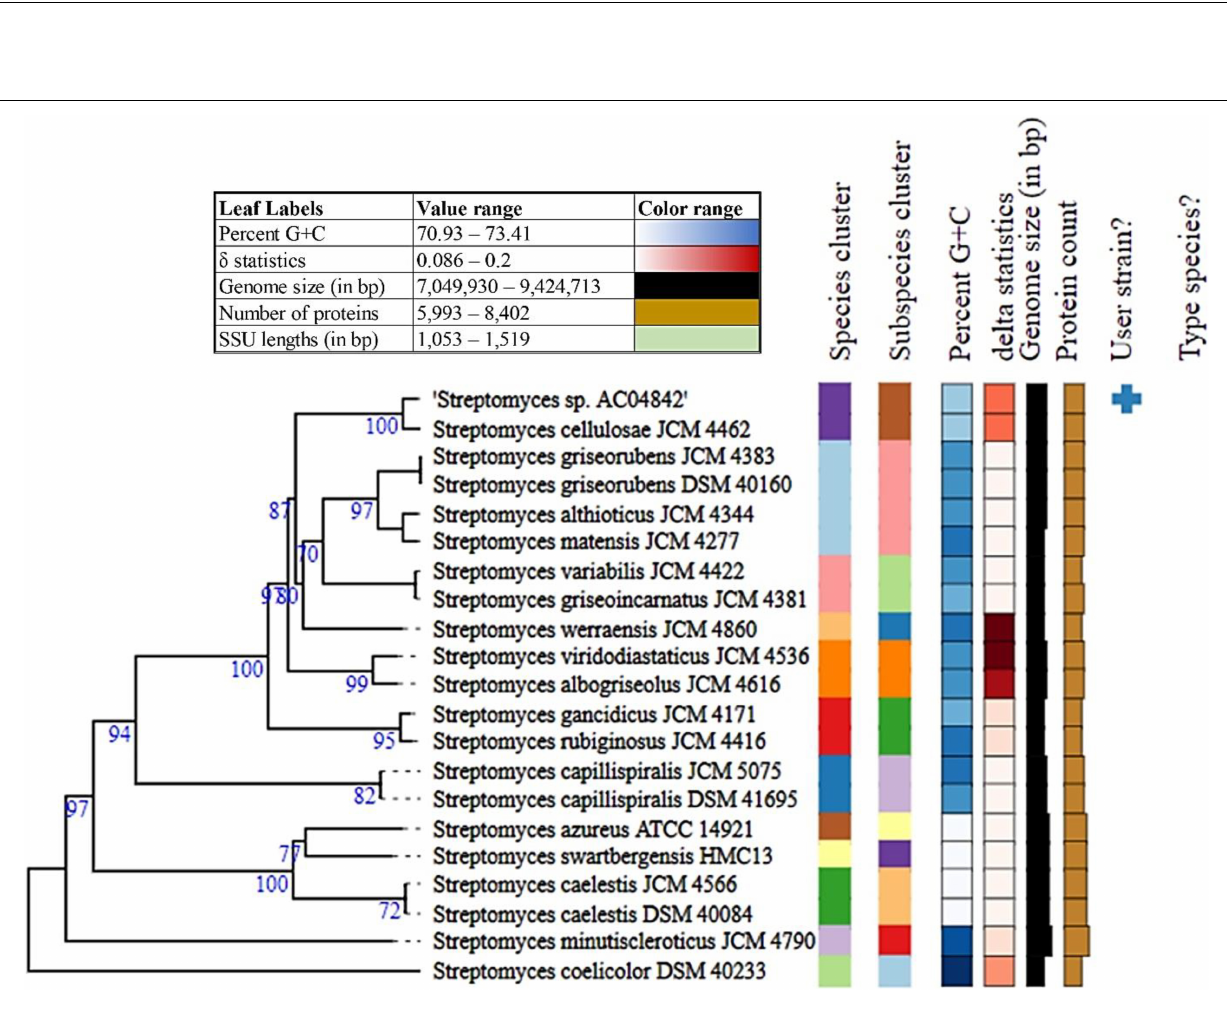
Frontiers in Microbiology |